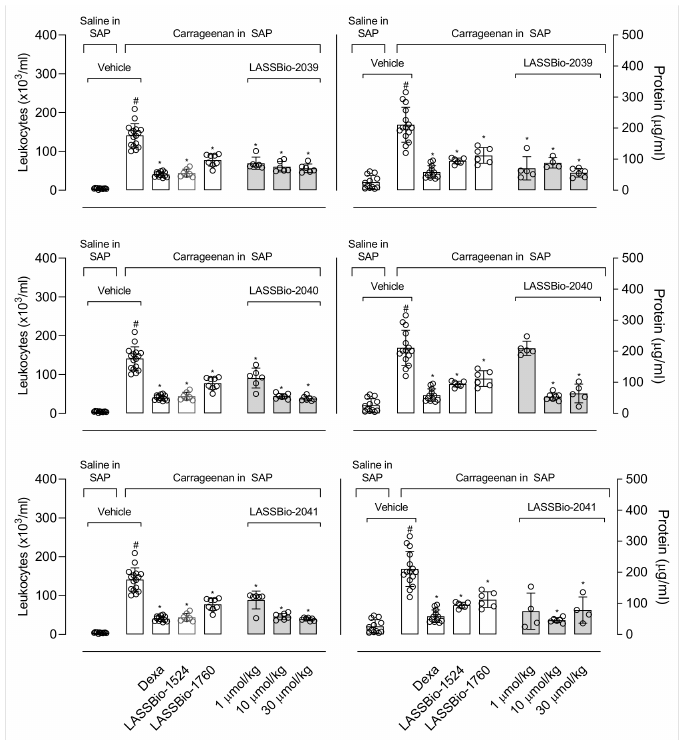
Figure 5. LASSBios reduce cell migration induced by carrageenan into the subcutaneous air pouch (SAP) and protein extravasated. Animals were pre-treated with vehicle, dexamethasone (6.5 µ mol/kg) or LASSBios (doses of 1, 10 or 30 µ mol/kg) 1 h before injection of saline (NaCl 0.9%) or carrageenan into the SAP. Results are expressed as media ± SD ( n = 5–12). Statistical significance was calculated in GraphPad Prism 8.0 (San Diego, CA, USA) using analyses of variance (ANOVA) followed by Tukey post-test with p < 0.01 (#) when comparing vehicle-treated group that received carrageenan injection into the SAP with vehicle-treated group that receives saline into the SAP or p < 0.01 (*) when comparing dexamethasone- or LASSBios-treated group that received carrageenan injection into the SAP with vehicle-treated group that receives carrageenan into the SAP. Data for the original compounds (LASSBio-1524 and LASSBio-1760) are original, independent duplicates of past results and have not been published